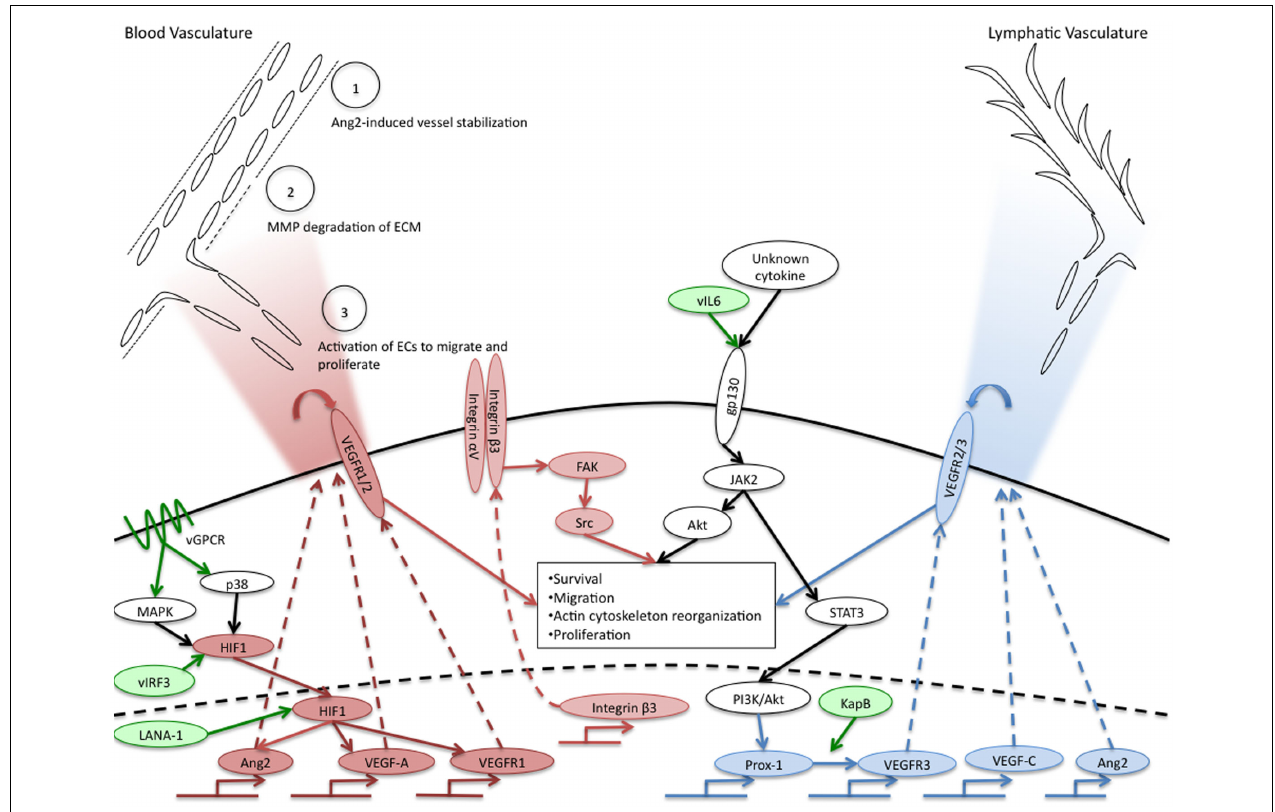
phenotypes of angiogenesis that are activated in normal endothelium by KSHV-infected cells and the gradient of cytokines secreted by KSHV-infected cells is indicated by the red gradient.The blue gradient in the upper right hand corner indicates the gradient of lymphangiogenic cytokines induced by KSHV-infected cells that could induce lymphangiogenesis.The central box indicates angiogenic phenotypes induced by KSHV in a cell autonomous fashion.